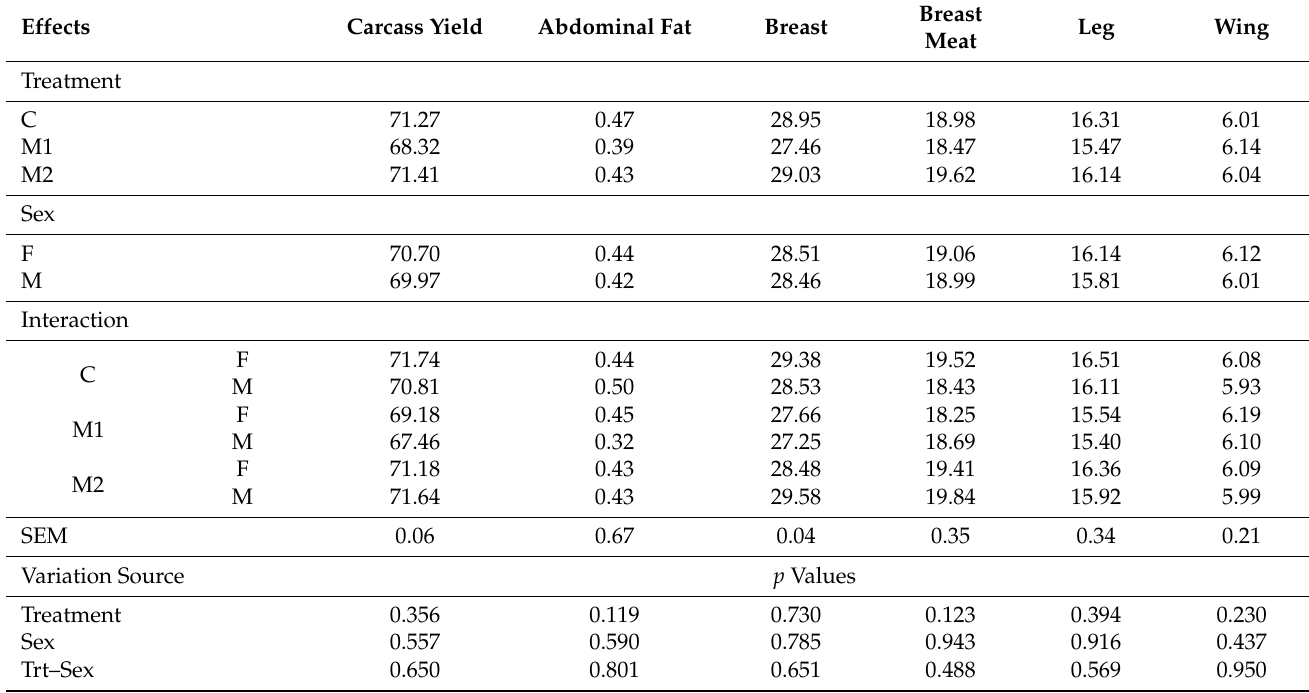
Table 5. The mean values of the carcass characteristics (%) and results of variance analyses.